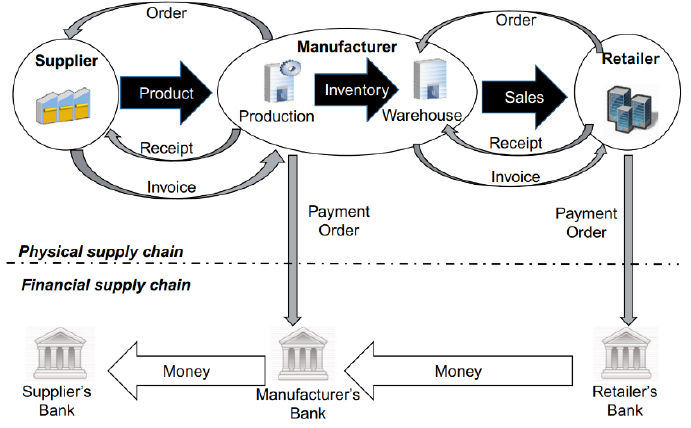
Figure 1. Physical and financial supply chain in banks (Silvestro and Lustrato 2014).